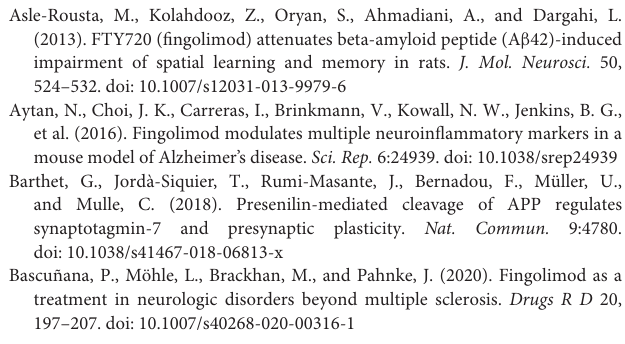
Supplementary Figure 1 | Levels of mRNA coding for synaptic proteins in 3-month-old mouse cortex: effect of A β PP expression and FTY720 administration. Levels of mRNAs measured with real-time PCR in the cerebral cortex of 3-month-old (adult) mice as described in Materials and methods. Results from A β PP-expressing mice were compared with those from control animals that did not inherit the transgene. Effect of FTY720 administration was assessed against vehicle-treated animals of the same group. Snap25 , synaptosomal-associated protein, 25kDa; Stx1a , syntaxin 1A; Nrxn1 , neurexin 1; Cplx1 , complexin 1; Syt, synaptotagmin 1; Syp , synaptophysin; Syn1 , synapsin 1; Nefl , neurofilament light; Nefm , neurofilament medium; APP − , animals without V717I A β PP transgene; APP + , mice expressing V717I A β PP transgene. n = 3–4 (for Nrxn1 , Cplx1 , Syt1 , and Syp ), n = 6–8 (for Snap25 , Stx1a, Syn1, Nefl, and Nefm ) measured in triplicate. Supplementary Figure 2 | Levels of mRNA coding for synaptic proteins in 3-month-old mouse hippocampus: effect of A β PP expression and FTY720 administration. Levels of mRNAs measured with real-time PCR in the hippocampus of 3-month-old (adult) mice as described in Materials and methods. Results from A β PP-expressing mice were compared with those from control animals that did not inherit the transgene. Effect of FTY720 administration was assessed against vehicle-treated animals of the same group. Snap25 , synaptosomal-associated protein, 25kDa; Stx1a , syntaxin 1A; Nrxn1 , neurexin